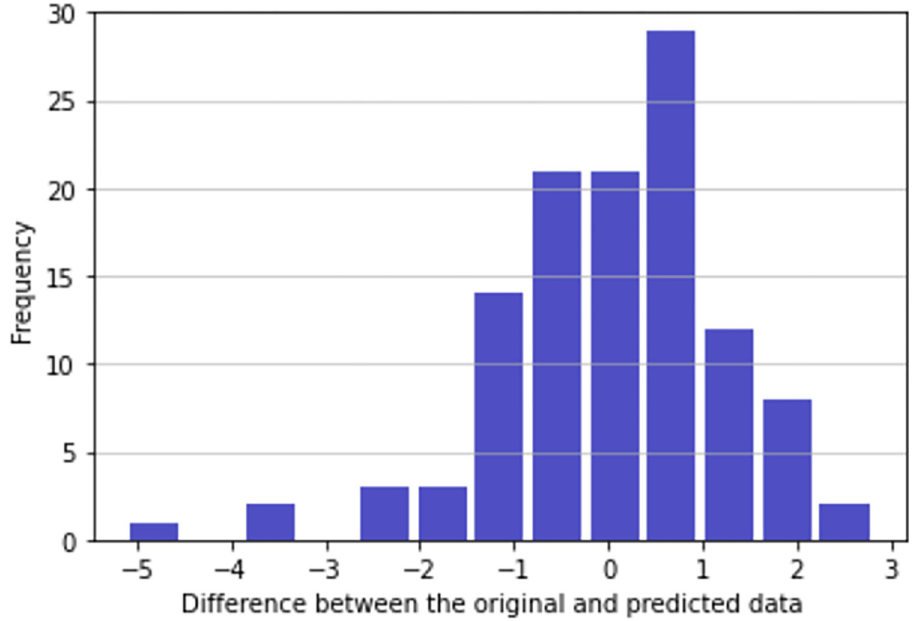
Fig 4. Difference between the value and the prediction a month before the final